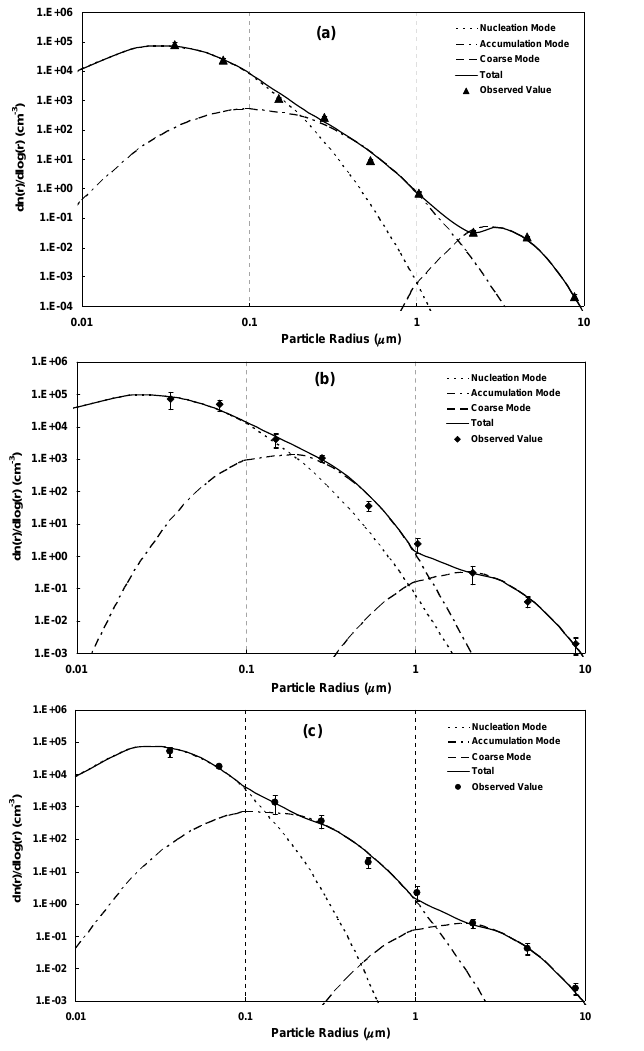
Fig. 5. Mean aerosol number distribution (a) prior to foggy days (mean of 2–8 December 2004) (b) during foggy days (mean of 12– 14, 20 and 29 December 2004) and (c) after foggy days (mean of 15–19, 21, 23–28 and 30 December 2004). The observed values are fitted with log-normal curves individually for the three modes, viz, nucleation, accumulation and coarse modes. The sum of the three modes is also shown.